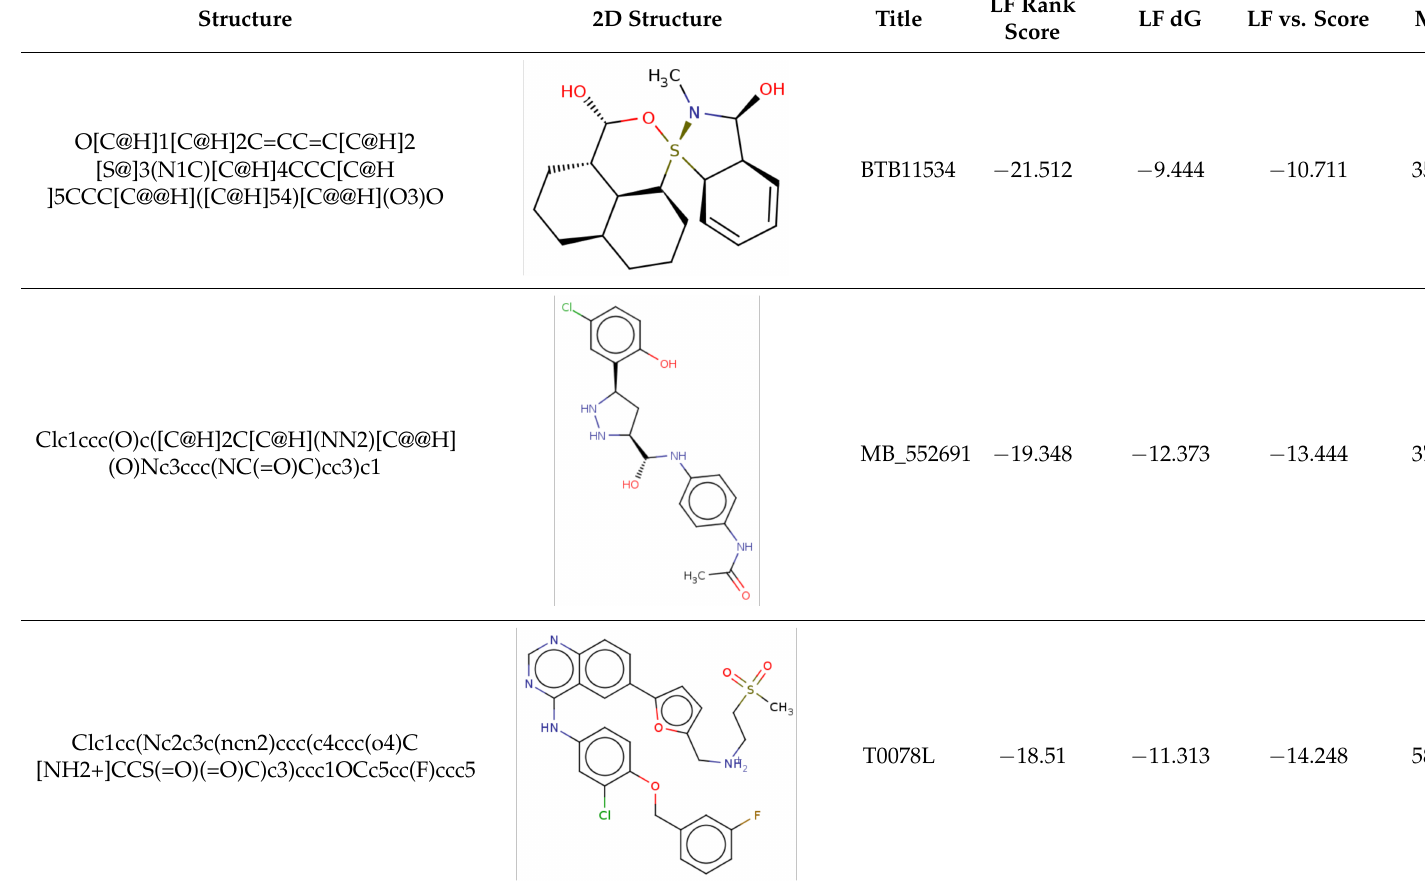
Table 2. The docking score and binding energies of the top five compounds docked to the PfDegP catalytic pocket (S1).